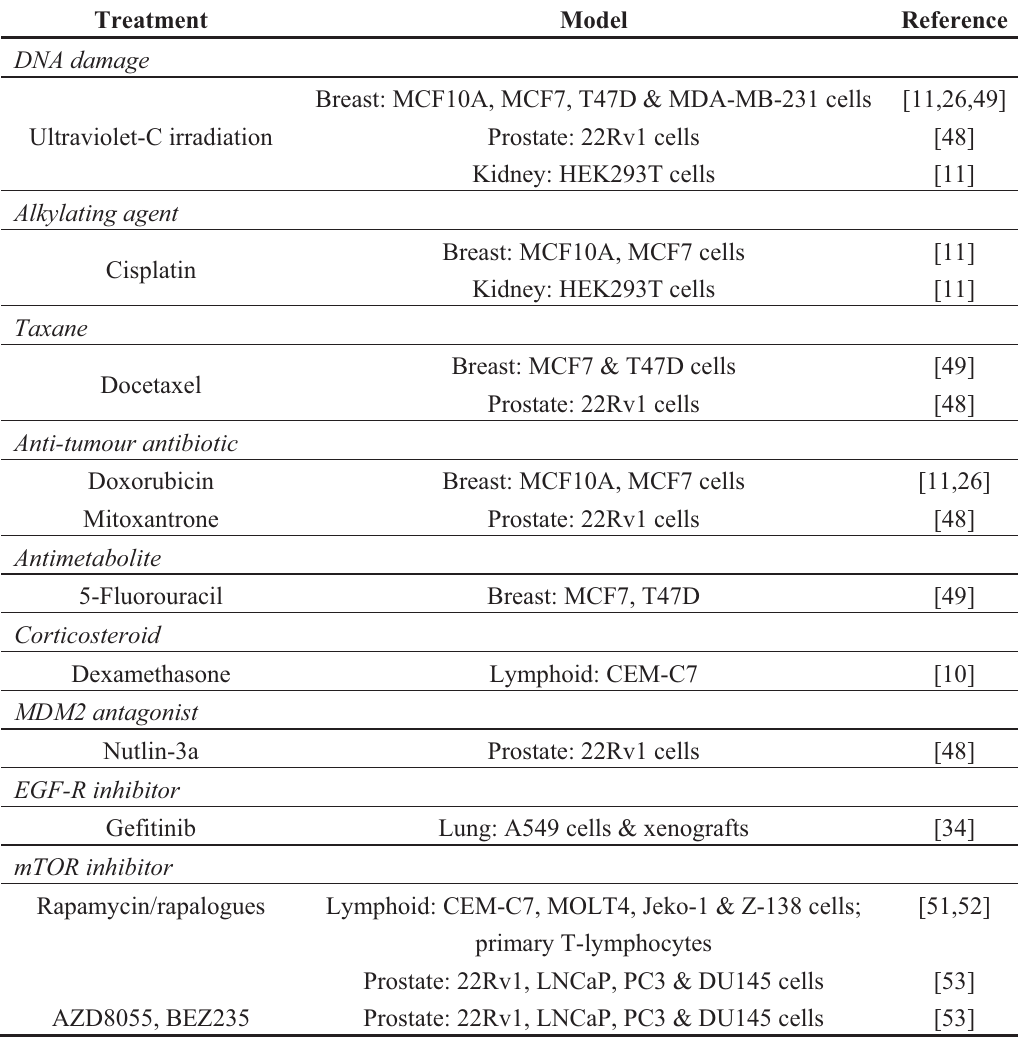
Table 2. Apoptotic stimuli which require GAS5 lncRNA for their